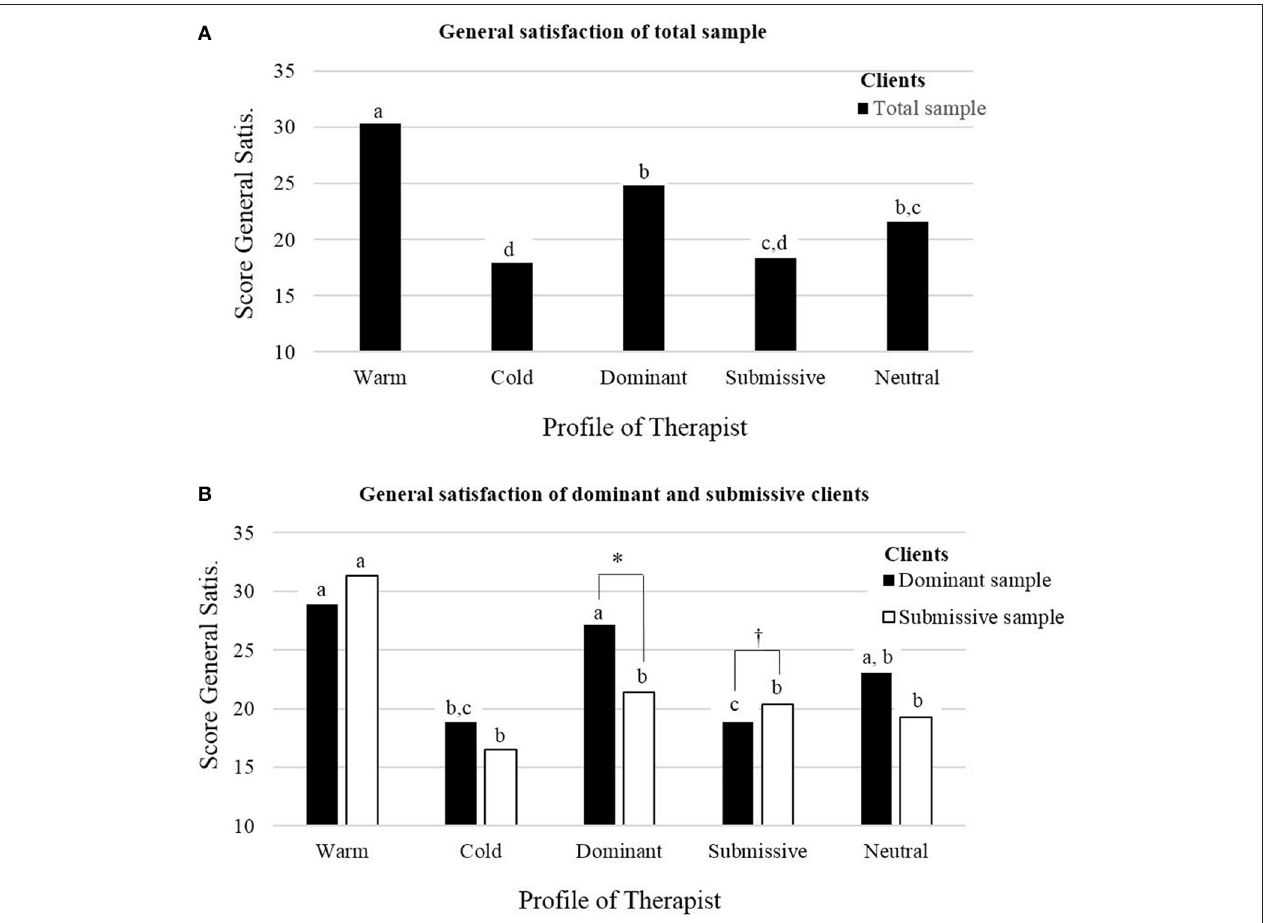
FIGURE 3 | Impacts on the general satisfaction of the “psychotherapist’s profile” (Within-Subjects)— (A) and the Interaction with “client’s profile” (Between-Subjects)— (B) . (A) General satisfaction of total sample. (B) General satisfaction of dominant and submissive clients. Presentation of the general satisfaction across the five experimental conditions (i.e., therapist’s interpersonal profiles) for the total sample ( n = 75), for the dominant sample ( n = 25) and for the submissive sample ( n = 27). The (A) presents the effect of the psychotherapists’ profile, illustrating hypotheses 1 and 2. The (B) presents the importance of taking into account the client’s profile in order to see the interaction with the psychotherapist’s profile, illustrating the hypothesis 3. Effect of the within-subjects variable in the case of interaction: means in a same sample with different superscripts are significantly different, using Bonferroni post-hoc tests in order to adjust the significance level. This adjustment involves an α -value divided by 10 (i.e., the number of comparisons). Effect of the between-subjects variable in the case of interaction: means across samples which are different are noted as: † p < 0.1, * p < 0.05.